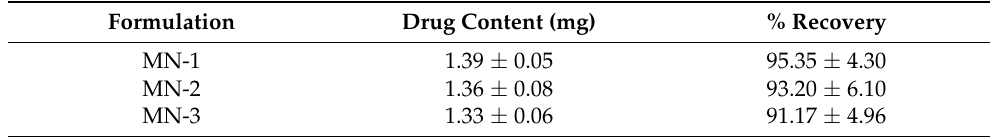
Table 6. The drug content of ALS from niosomal DMNs; MN-1, MN-2, and MN-3 (Mean ± SD, n =